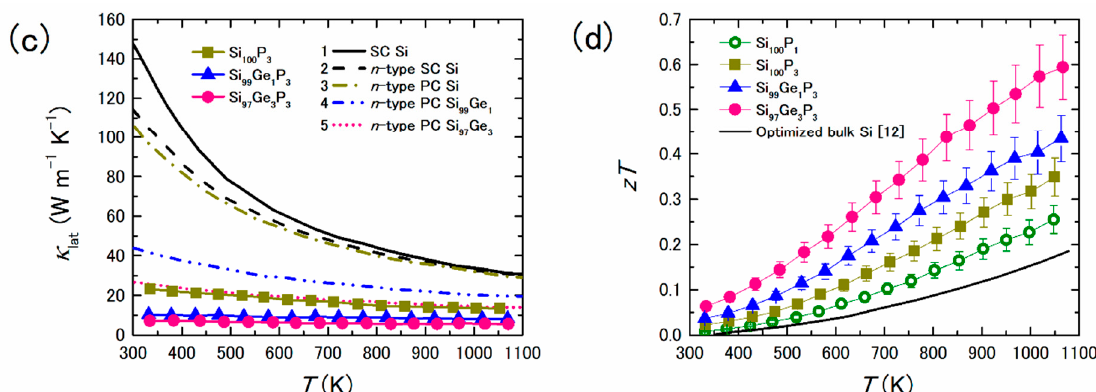
Figure 2. ( a ) Seebeck coefficient S and ( b ) Hall carrier mobility µ H as a function of Hall carrier concentration n H at 300 K for various types of Si. Temperature dependences of ( c ) lattice thermal conductivity κ lat and ( d ) dimensionless figure of merit zT of nanostructured bulk Si containing small amounts of Ge. Reproduced with permission from Ref. [26]. Copyright 2009, the Royal Society of Chemistry.